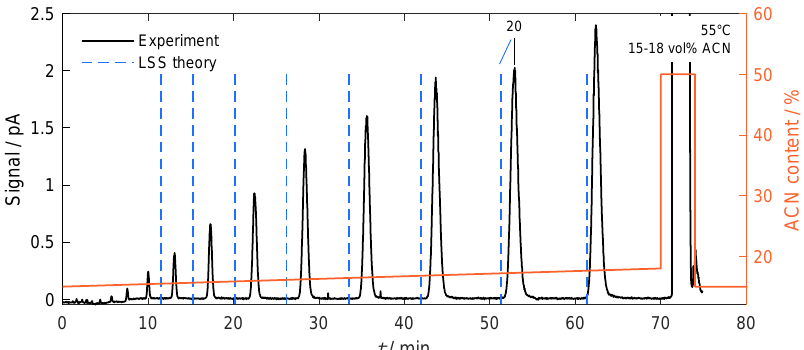
Figure 9. Linear gradient experiment under diluted conditions (black) and comparison of retention times to the prediction by LLS theory (dashed blue lines). For better orientation, homolog n = 20 is marked. The orange line marks the solvent gradient (right axis). The dwell volume required to apply Equation (5) was measured as 11.4 mL. Conditions: Linear gradient from 15 vol% to 18 vol% ACN in 70 min, followed by a forced elution step at 70 min; 55 ◦ C; sample 50 µ L of 0.05 g/L PEG 1000 in water.